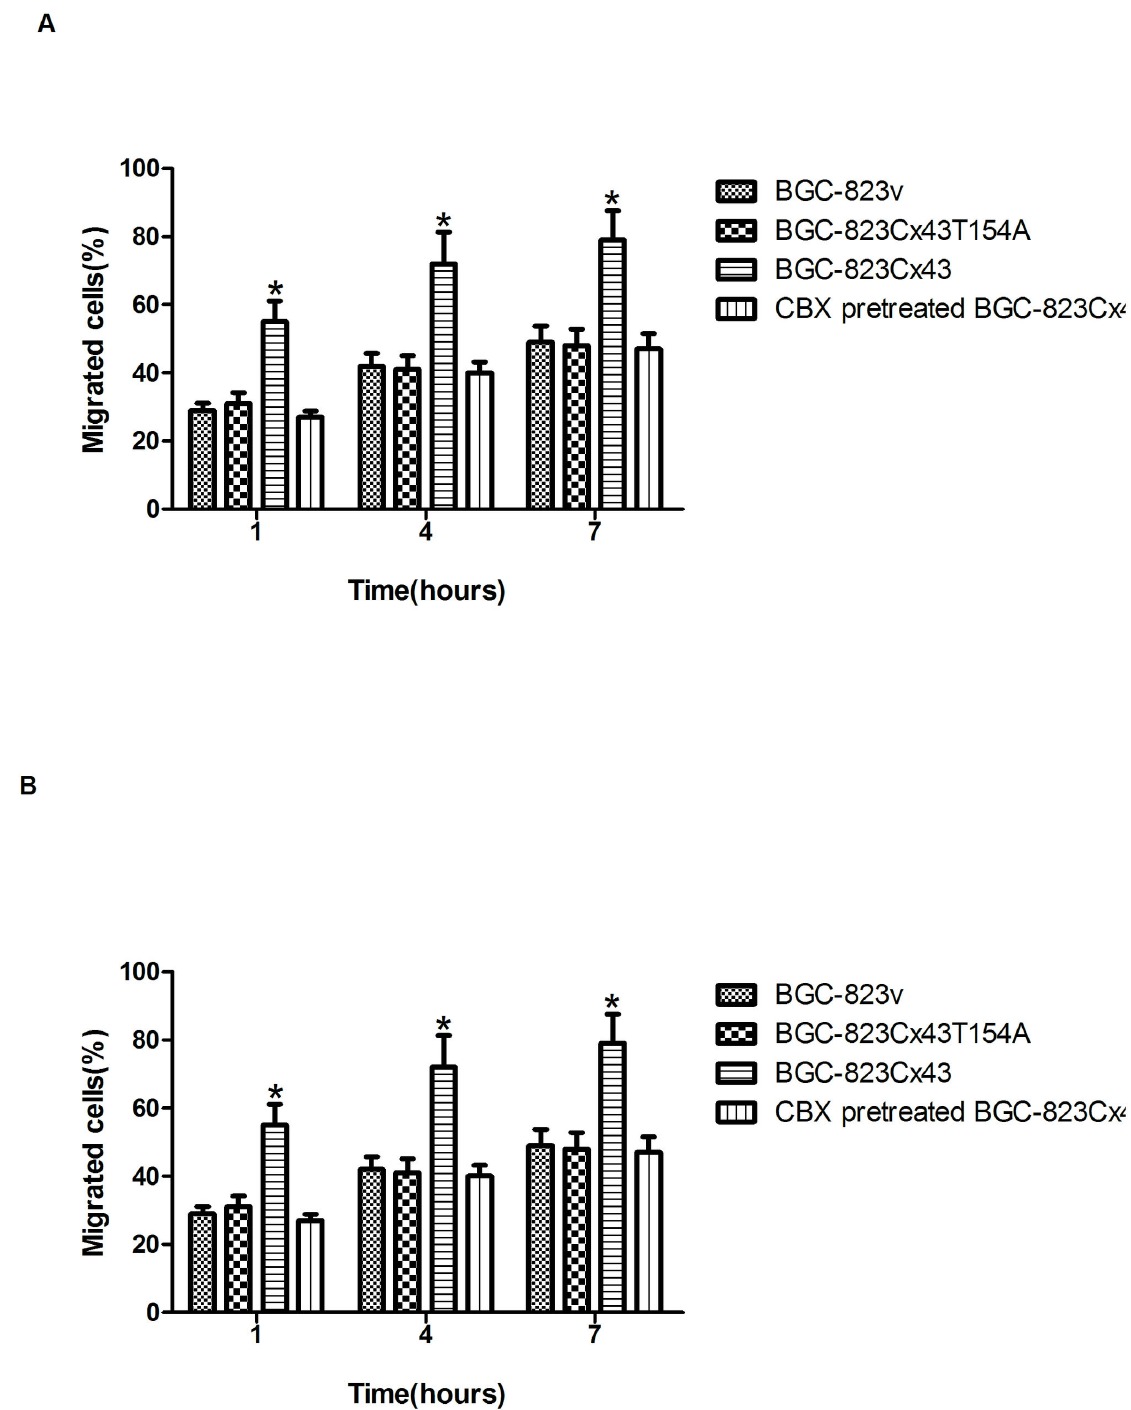
Figure 5. Connexin 43 mediated gap junctional intercellular communication enhances tumor cell diapedesis. Adherent cells in the process of diapedesis and cells that had completed diapedesis were scored together as having migrated cells successfully. (A) Percentage of adherent migrating cells in BGC-823 group cells(%), compared to BGC-823v (control), a significant increase in diapedesis of BGC-823Cx43 cells was observed at 1, 4 and 7 h (*p<0.05); (B) Percentage of adherent migrating cells in SGC-7901 group cells(%), compared to SGC-7901v (control), a significant increase in diapedesis of SGC-7901Cx43 cells was observed at 1, 4 and 7 h (*p<0.05). doi: 10.1371/journal.pone.0074527.g005 PLOS ONE |